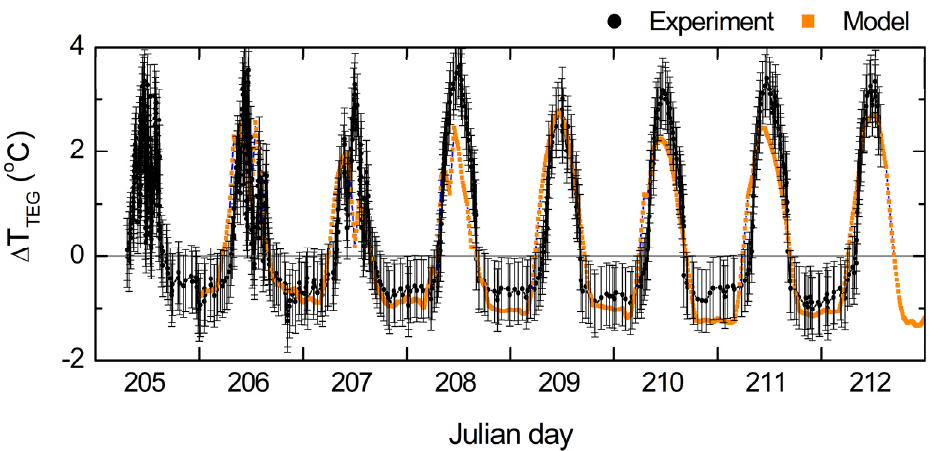
Figure 10. Experimental (black dots) and model (orange dots) data.